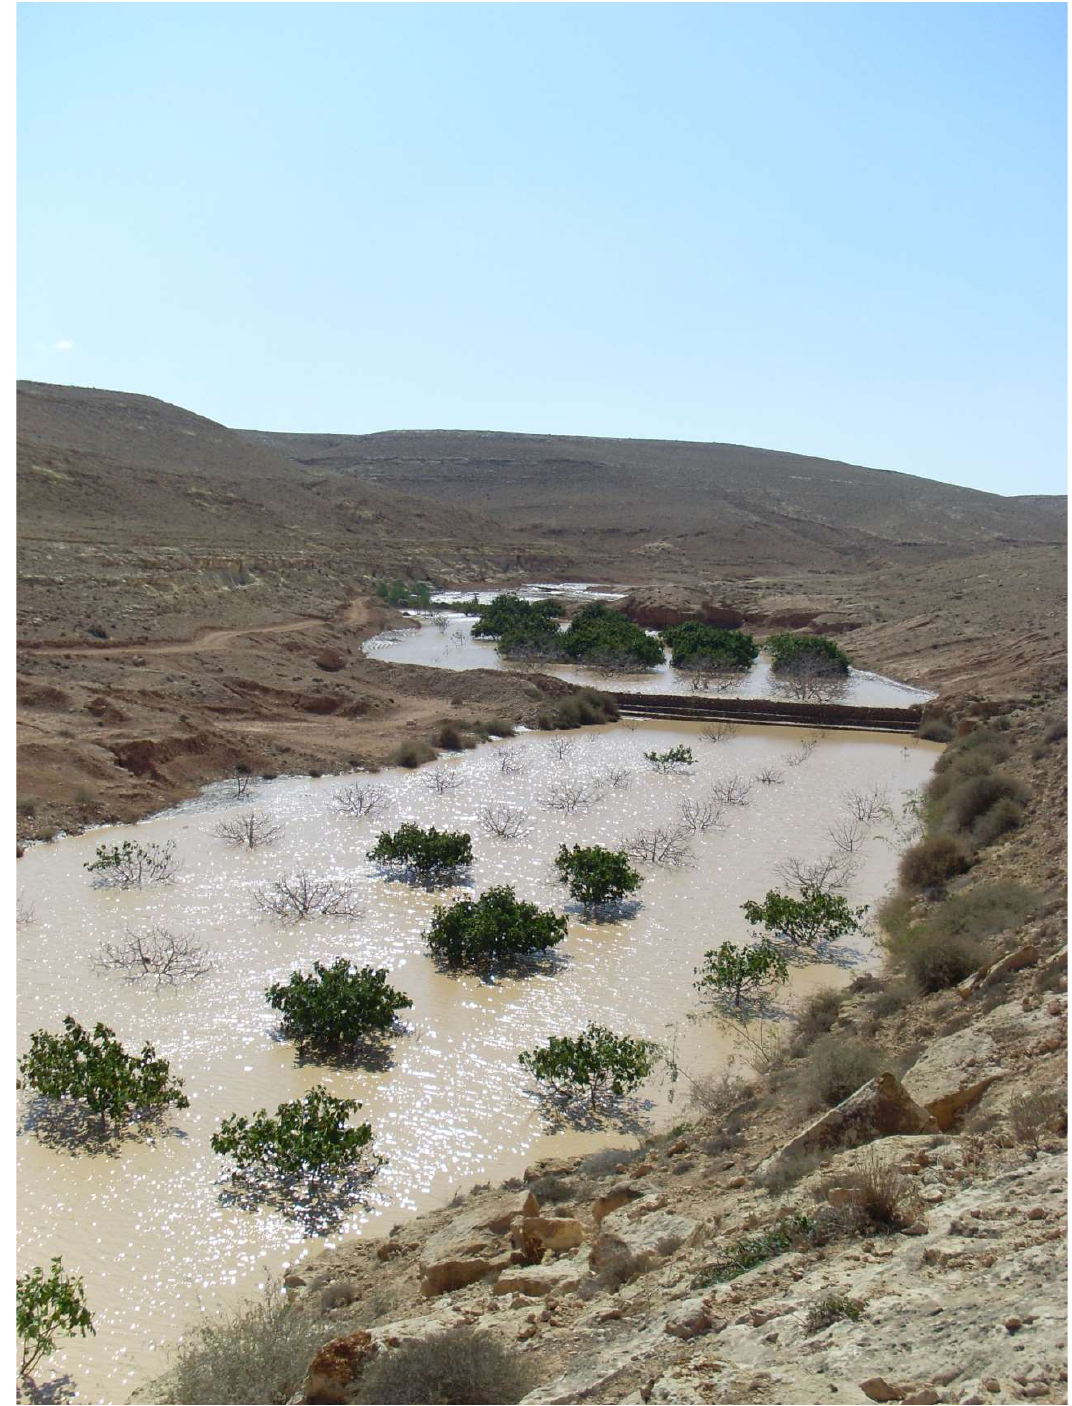
Figure 14. Wadi bed with fig trees and ponding water behind the terraces after rainfall. Photograph: A. Nicolay.